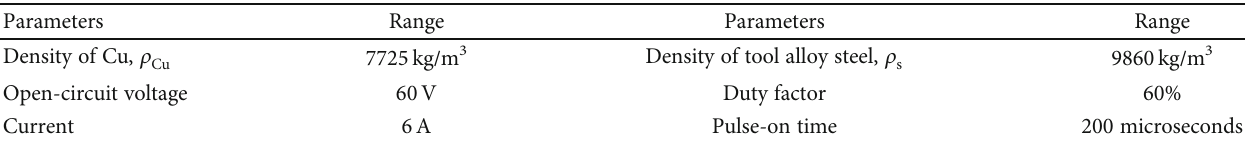
Figure 1: Schematic of electrode fabrication processes. Table 1: EDM test run